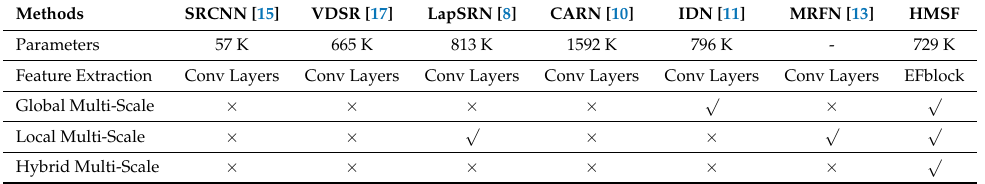
Figure 9. PSNR of recent CNN models for scale of 4 × on Set5 [49]. The redpoint result is from our HMSF. Our model achieves the best performance, although the number of network parameters is relatively small. Table 8. Comparison of parameters and feature extraction layers of several methods with 2 ×